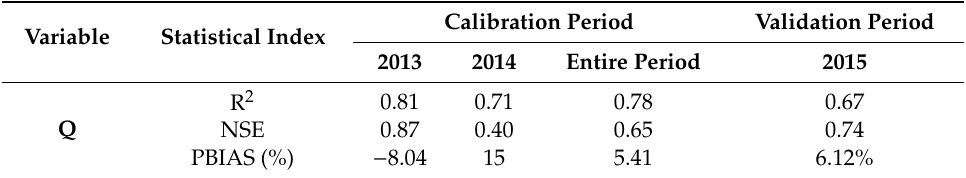
Table 4. Performance statistics for the calibrated APEX-Paddy model, including the coe ffi cient of